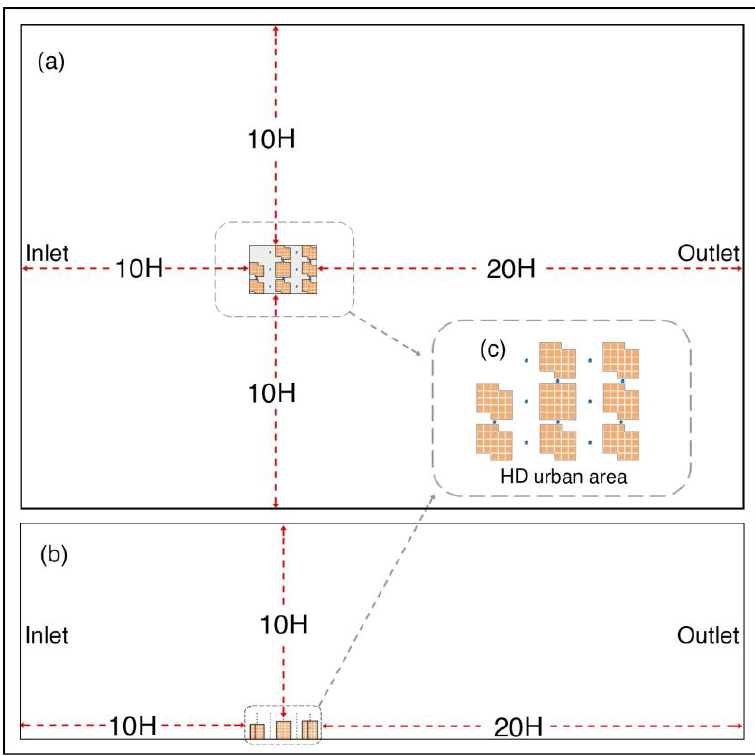
Figure 3. Computational domain defined for the computational fluid dynamics (CFD) simulations.